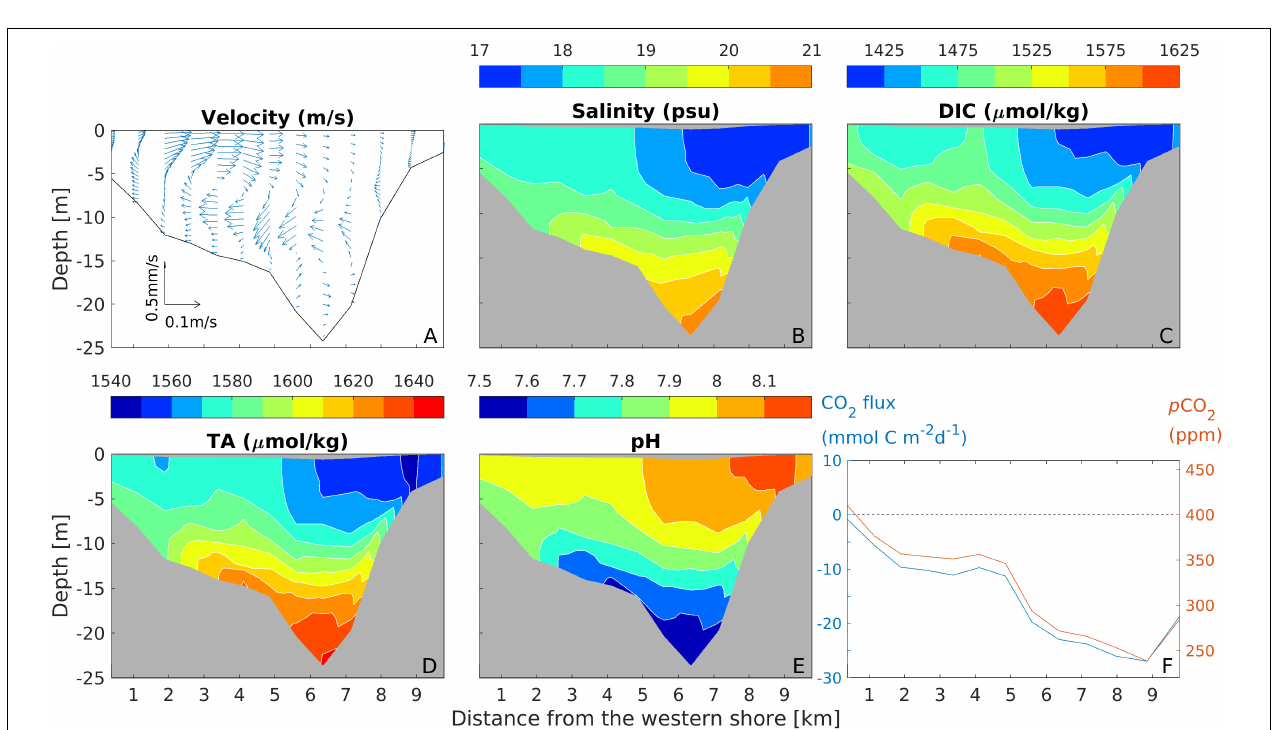
FIGURE 6 | Distributions of lateral-vertical velocity vector (A) , salinity (B) , DIC (C) , TA (D) , pH (E) , and surface p CO 2 (red) and air-sea CO 2 flux (blue) (F) and at the mid-bay section during the up-estuary wind event.